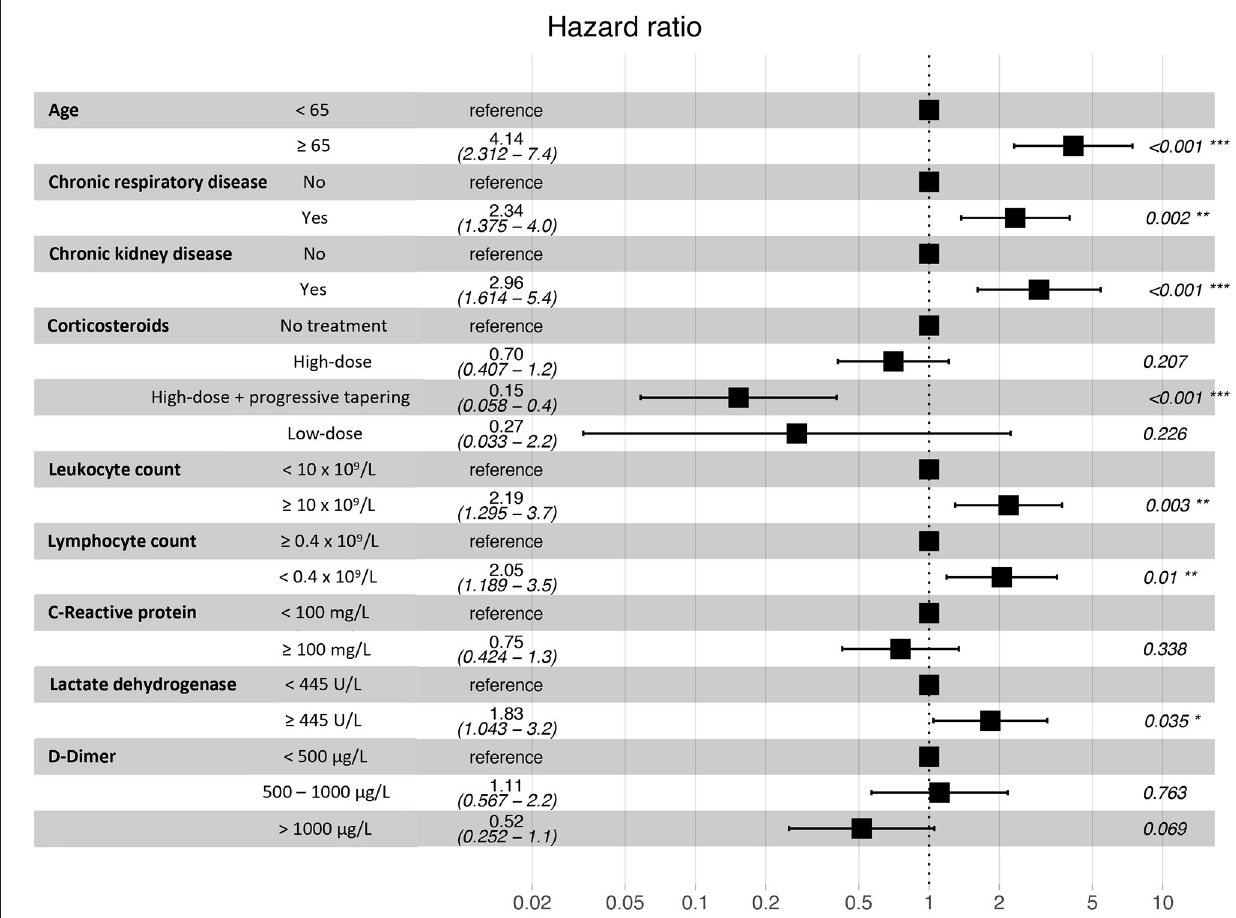
FIGURE 4 | Multivariable Cox proportional hazards model for the assessment of in-hospital death